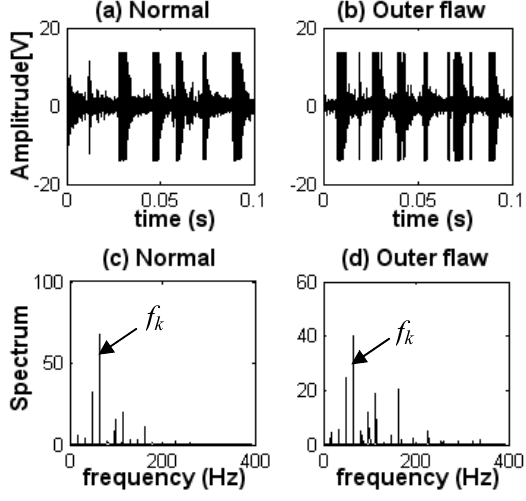
Figure 1. Example for fault diagnosis of a bearing. (a) Vibration signal at the normal operation. (b) Vibration signal in the outer-race defect state. (c) Envelope spectrum at the normal operation. (d) Envelope spectrum in the outer-race defect state.